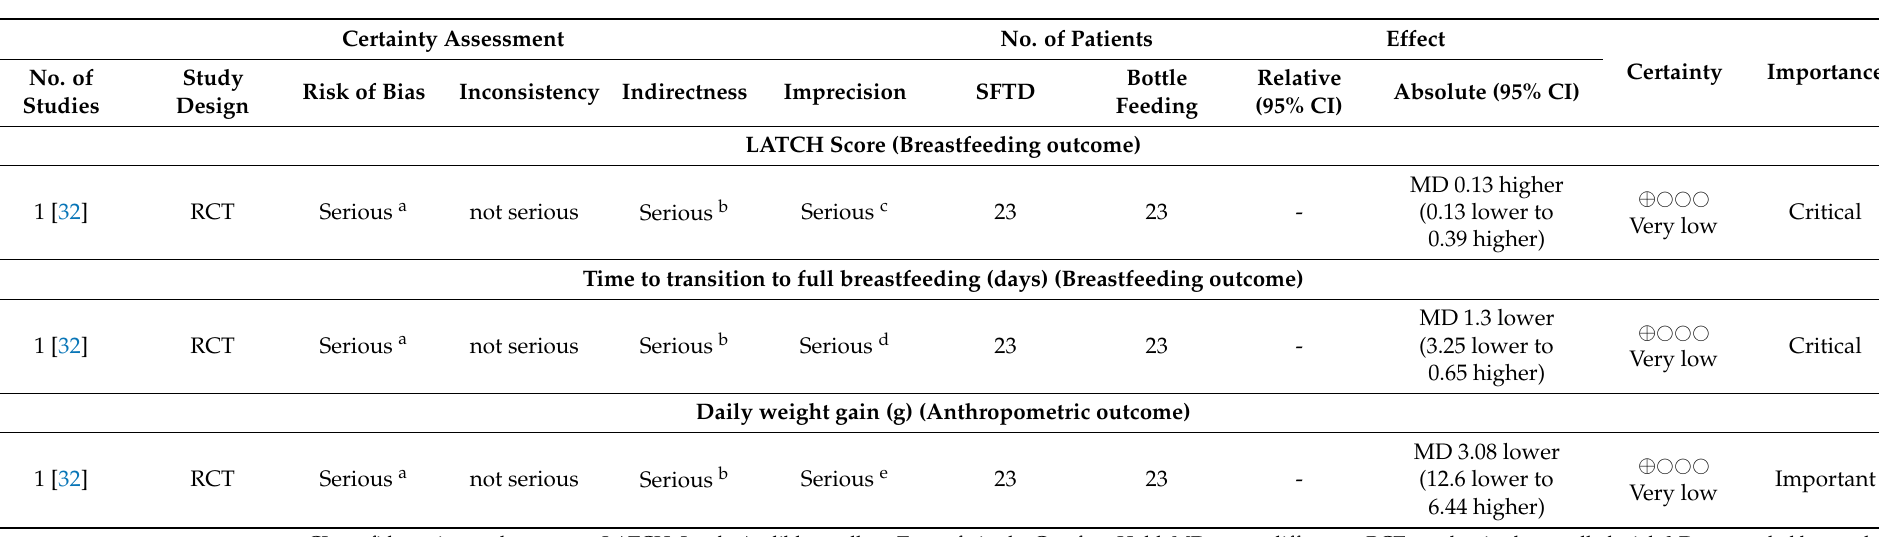
Table 4. GRADE evidence profile: Supplemental feeding tube device (SFTD) compared to bottle feeding for infants u6m with growth faltering. Certainty